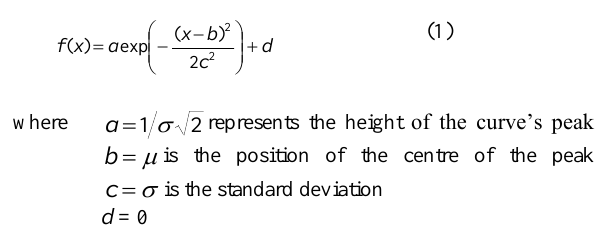
Figure 1. Example of wave flood calculation. The maximum altitude of the wave, either theoretical or calculated from hydrographs, corresponds at least to a 2 m level increase of the river surface. Several tests were realized in order to know exactly the critical altitude limit for inundation triggering in the study zone. This limit corresponds to a 2.7 m wave height for the peak of the attenuated Gaussian curve. In a second step, the Gaussian curve and their associated upstream waves are calculated using the previous information following the entire skeleton. In this case the variation downstream of the factor  will produce the attenuation of the wave as reported in Fig. 1. At this point, one can calculate the percentage of loss as water volume is displaced